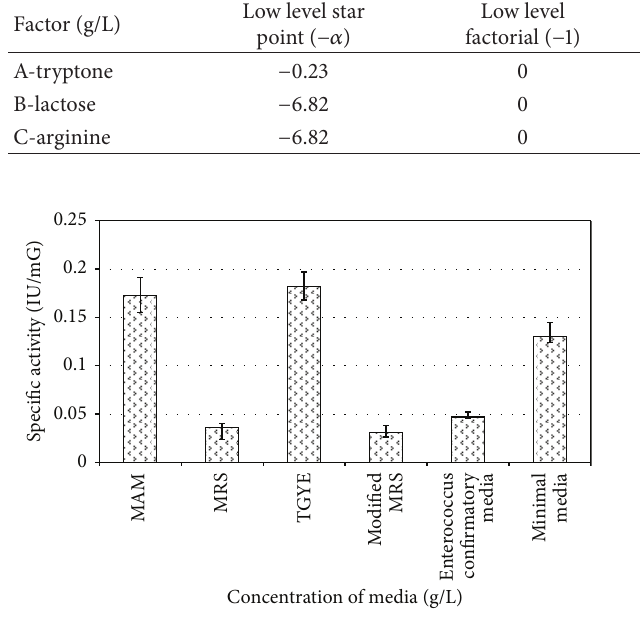
Figure 2: Effect of culture media on specific ADI activity of E. faecium sp. GR7. Results are expressed as the mean ± S.D ( 𝑛 = 3 ), 𝑃 value < 0.05.